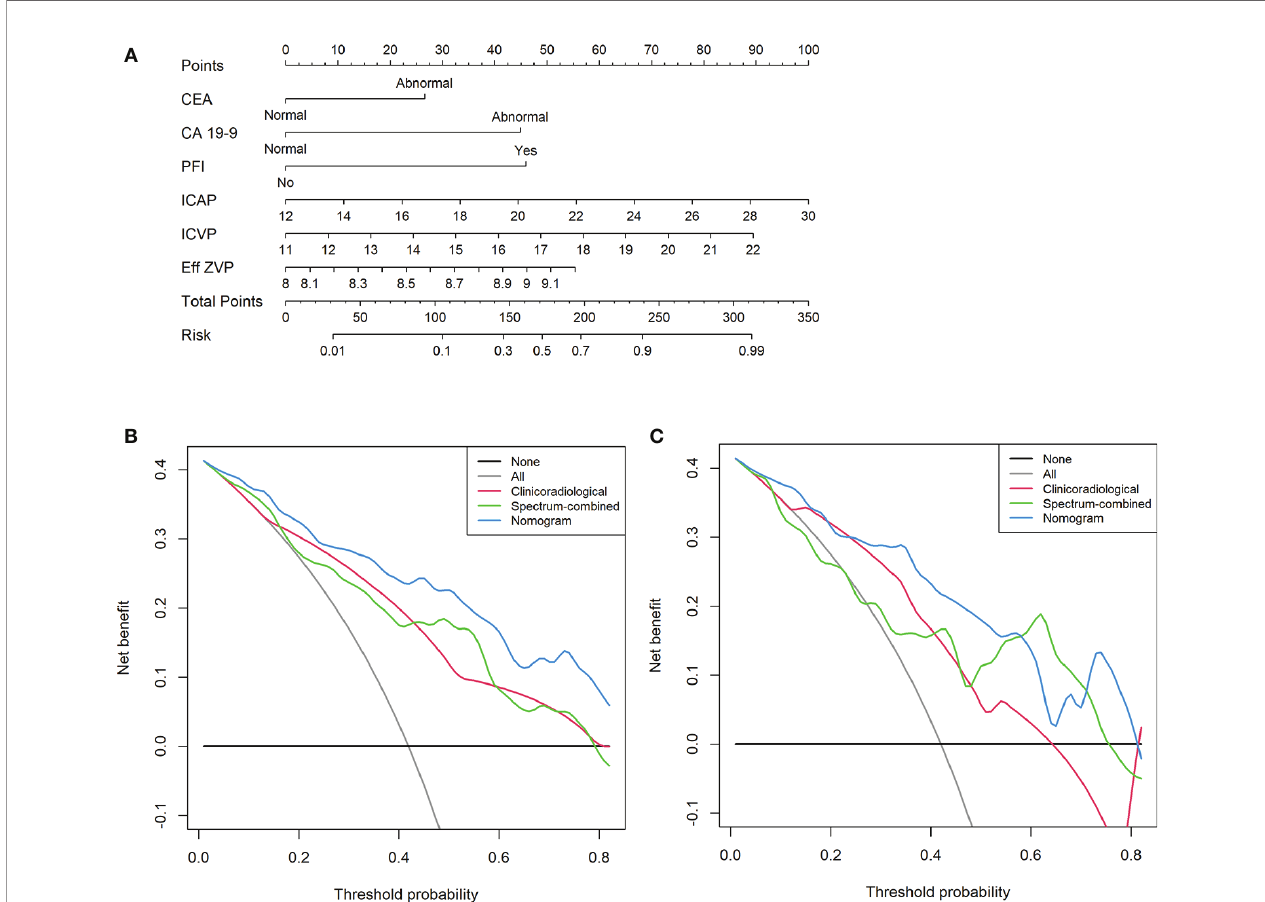
FIGURE 5 | A multiparametric clinical – DESCT nomogram for predicting the probability of LNM in CRC patients (A) . Decision curve analysis (DCA) of the clinical – DESCT nomogram, clinicoradiological model, and spectrum-combined model in the training cohort (B) and validation cohort (C)